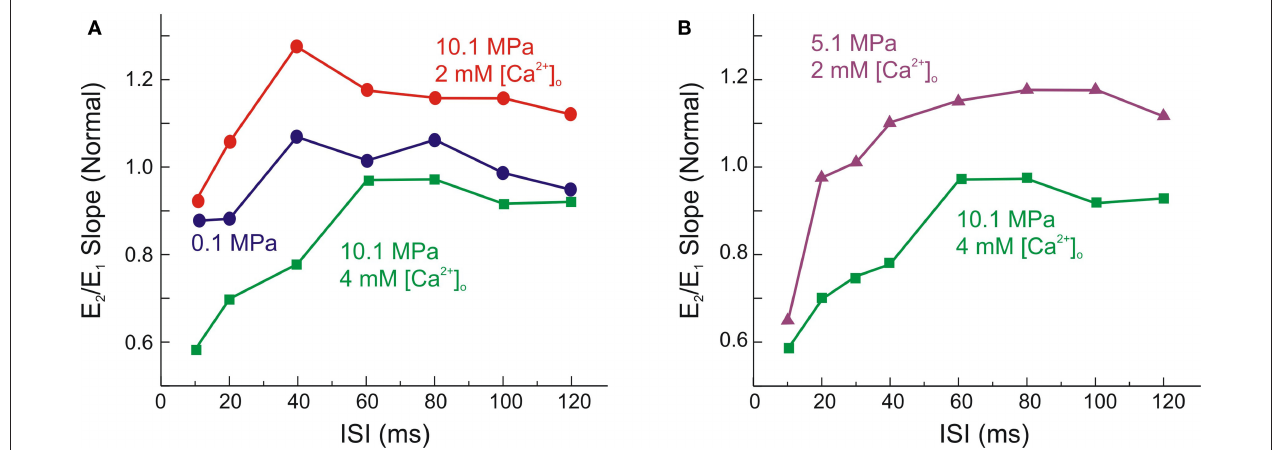
restored the slope of E , but increased PPD for short ISI and abolished the 1 later phase of PPF for ISI 35–120 ms. (B) Comparison between PPM at HP partially o